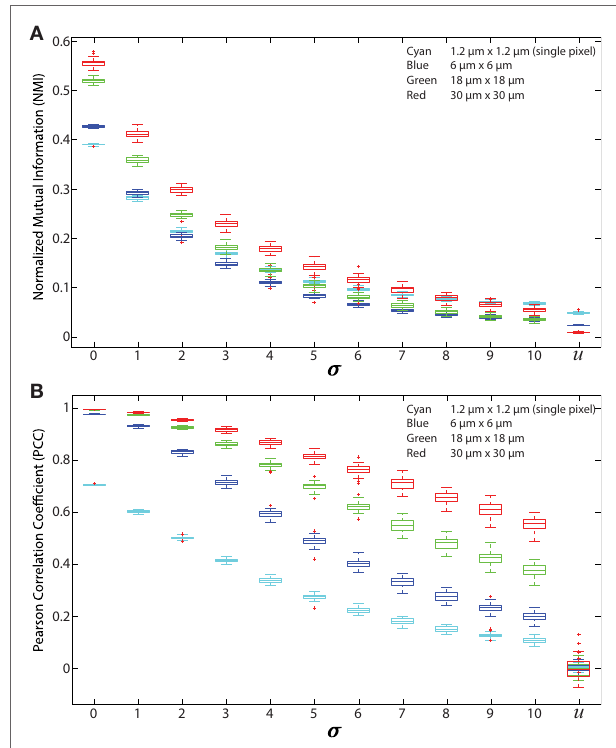
FigUre 4 | Regionalized PCC and NMI on simulated data. Simulated images are 512 × 512 pixels with 500 red and 500 green 11 × 11 pixel square-shaped cells. The red cell locations are chosen from a Gaussian distribution centered at the location of green cells with SD ( σ ), which ranges from 0 to 10 and u . u indicates that the cells are placed uniformly at random within the images and with uniform random color intensity. (a) NMI calculated on simulated images with regions of sizes 6 μ m × 6 μ m (blue), 18 μ m × 18 μ m (green), 30 μ m × 30 μ m (red), and single pixels (1.2 μ m × 1.2 μ m, cyan). (B) PCC of simulated images using the same